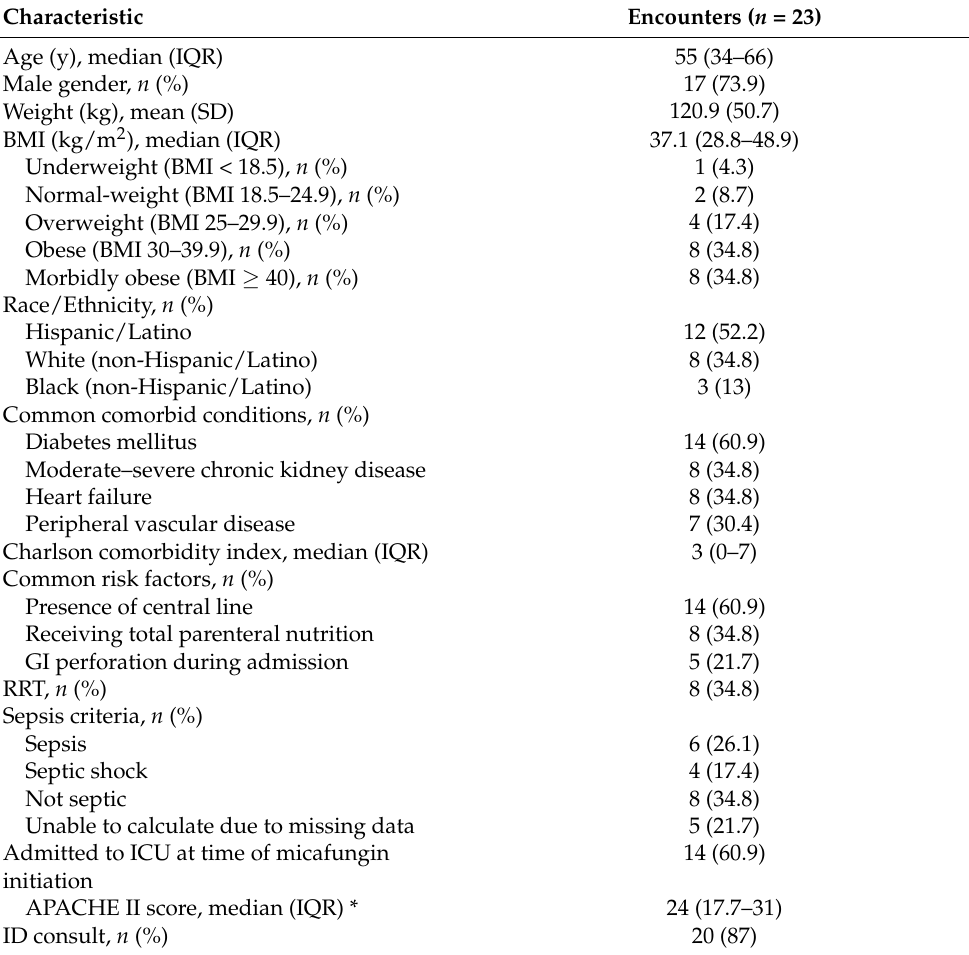
Table 1. Baseline demographics and clinical